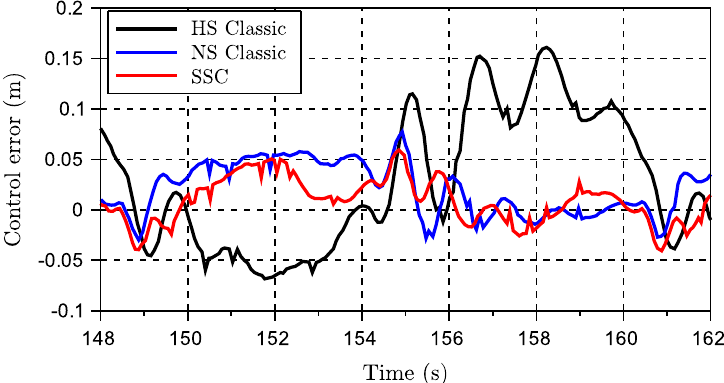
Figure 21. Control error for scenario